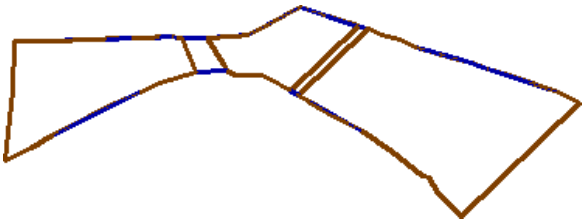
Figure 7: The basis of the field after merging of three disjoint pieces into one polygon (source: the authors’ own edition )